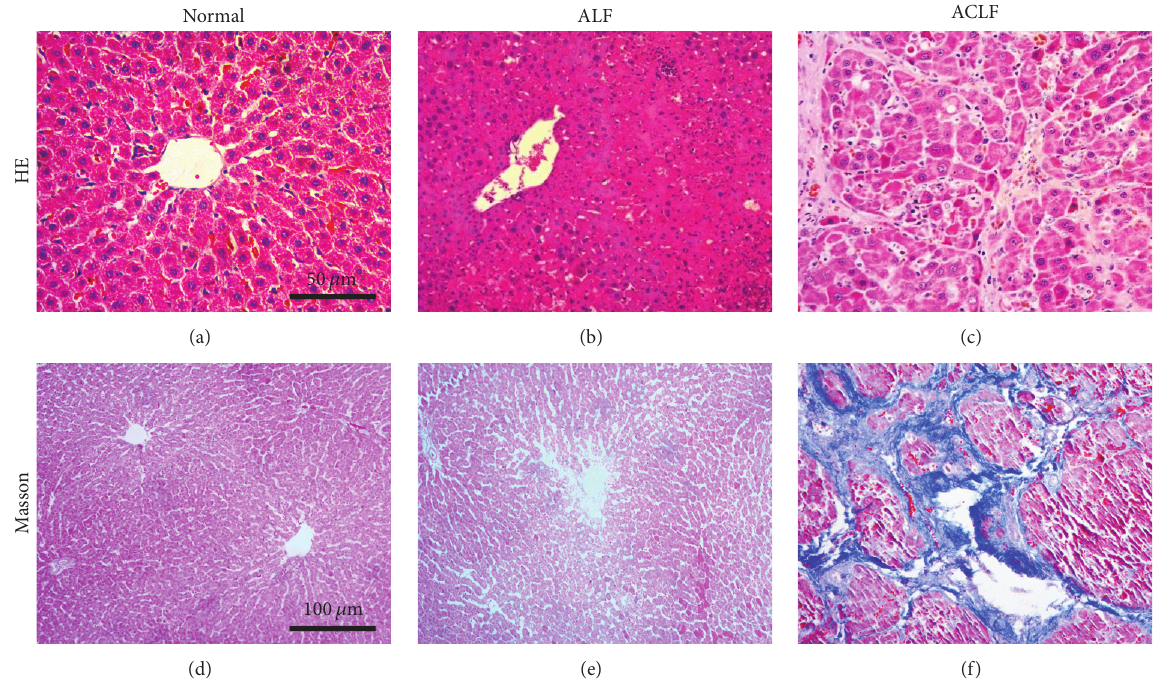
Figure 2: Pathological features of liver tissue under light microscope by HE (magnification 400x) and Masson staining (magnification 200x). Liver sections of normal, ALF, and ACLF group were stained with HE (a, b, and c) and Masson (d, e, and f), respectively. (a, d) Normal: the rats were from 0 h subgroup in ALF model; (b, e) “12h” subgroup in ALF group; (c, f) “12h” subgroup in ACLF group (HE: hematoxylin and eosin staining; ALF: acute hepatic failure; ACLF: acute-on-chronic liver